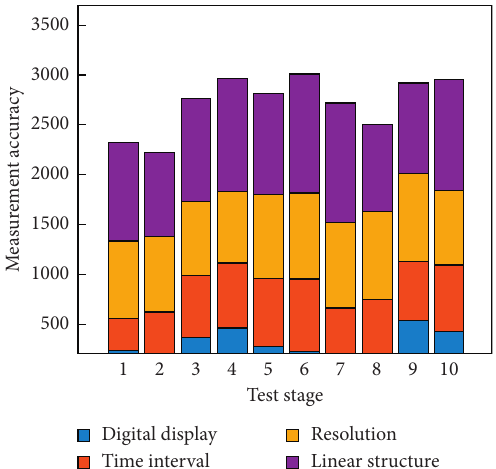
Figure 2: Effective improvement of the sensor’s displacement measurement accuracy.